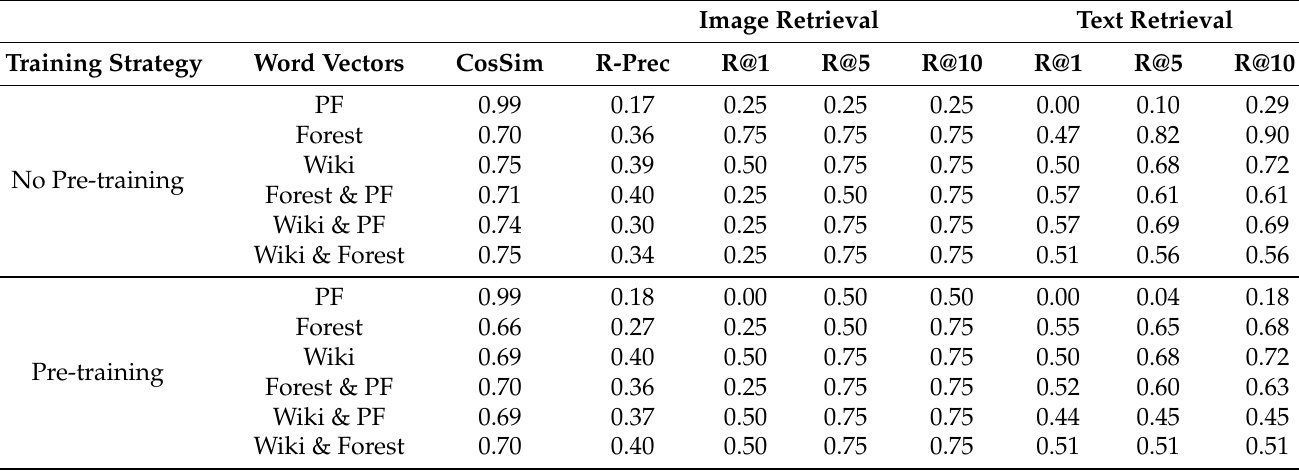
Table 2. Choice of corpus and training strategy both influence the performance of the visual semantic model. Recall at 1 is higher on average for image retrieval when the network is not pre-trained. Pre-training the network on the change detection task slightly improves R-precision and recall at 10 for image retrieval, on average, when the query is a word and the result is an image pair. The models trained with the corpora that were aligned with the PF corpus obtained the best results in the no-pre-training strategy. For the pre-training strategy, the model trained on the Forest corpora reached the best recall at 1; however, it performed less well than the top performers under the no-pre-training strategy for this same